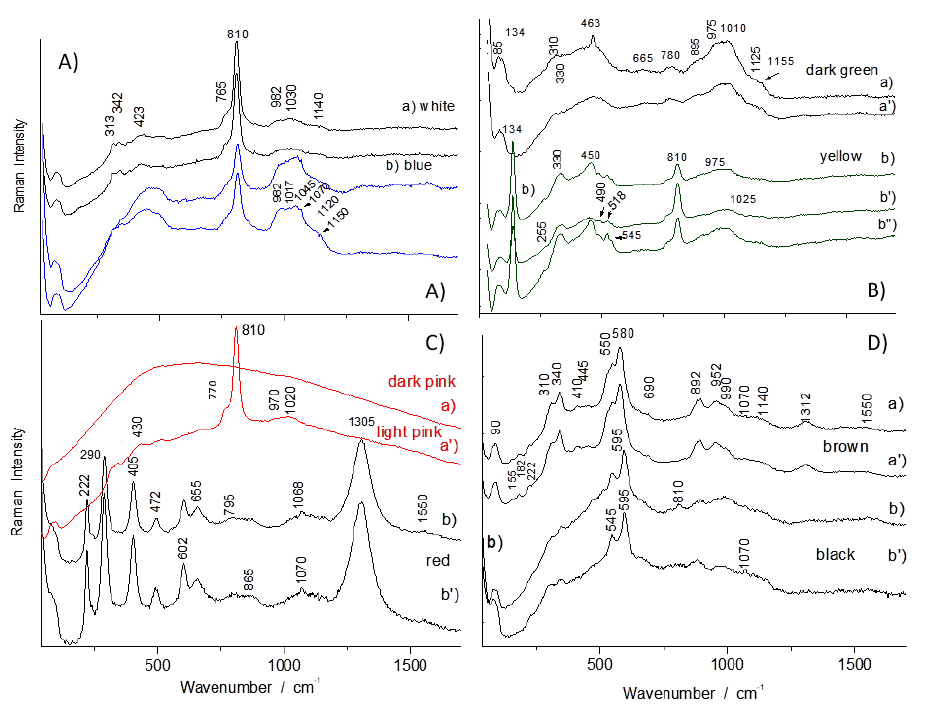
Figure 11. Representative portable X-ray fluorescence spectrometry (pXRF) spectra recorded on the R975 bottle for the metal and enamelled areas with different colours. A zoom of the region showing Sn and Sb elements is given in a).